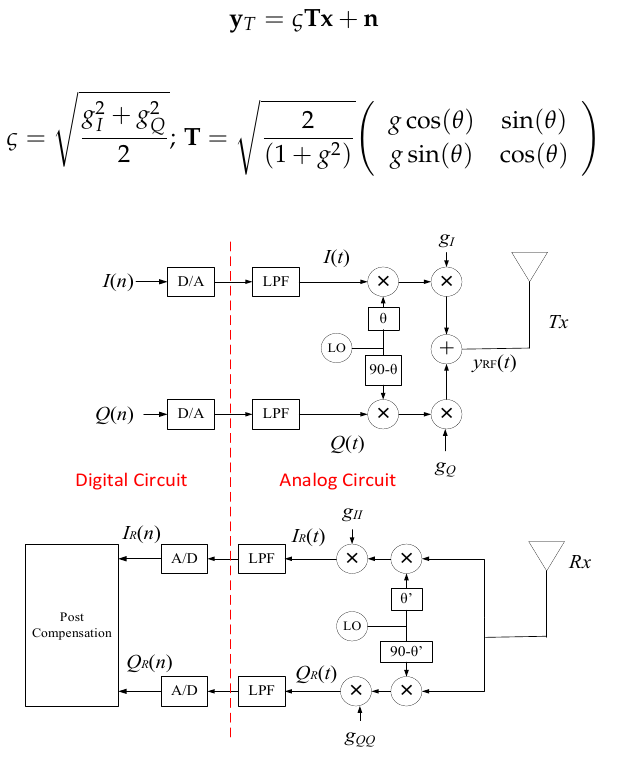
Figure 1. Block diagram of transceiver system with modulator’s and demodulator’s imperfections.